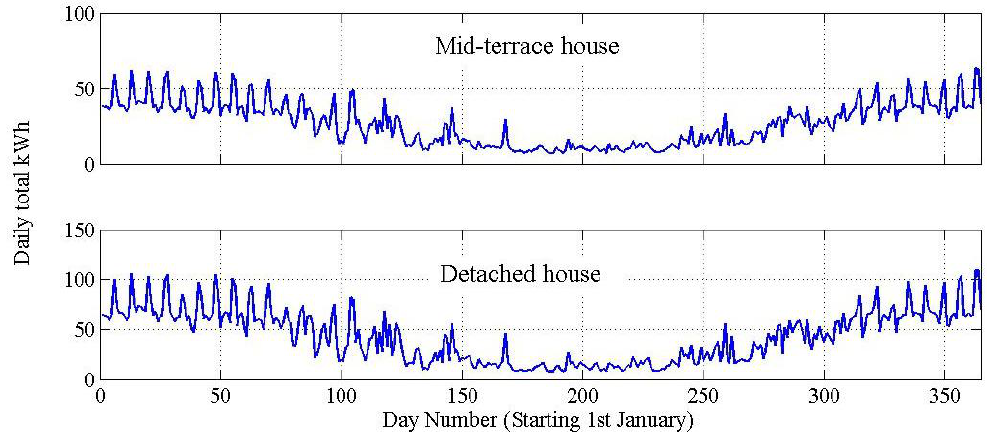
Figure 1. Simulated distributions of energy demand due to heating and hot